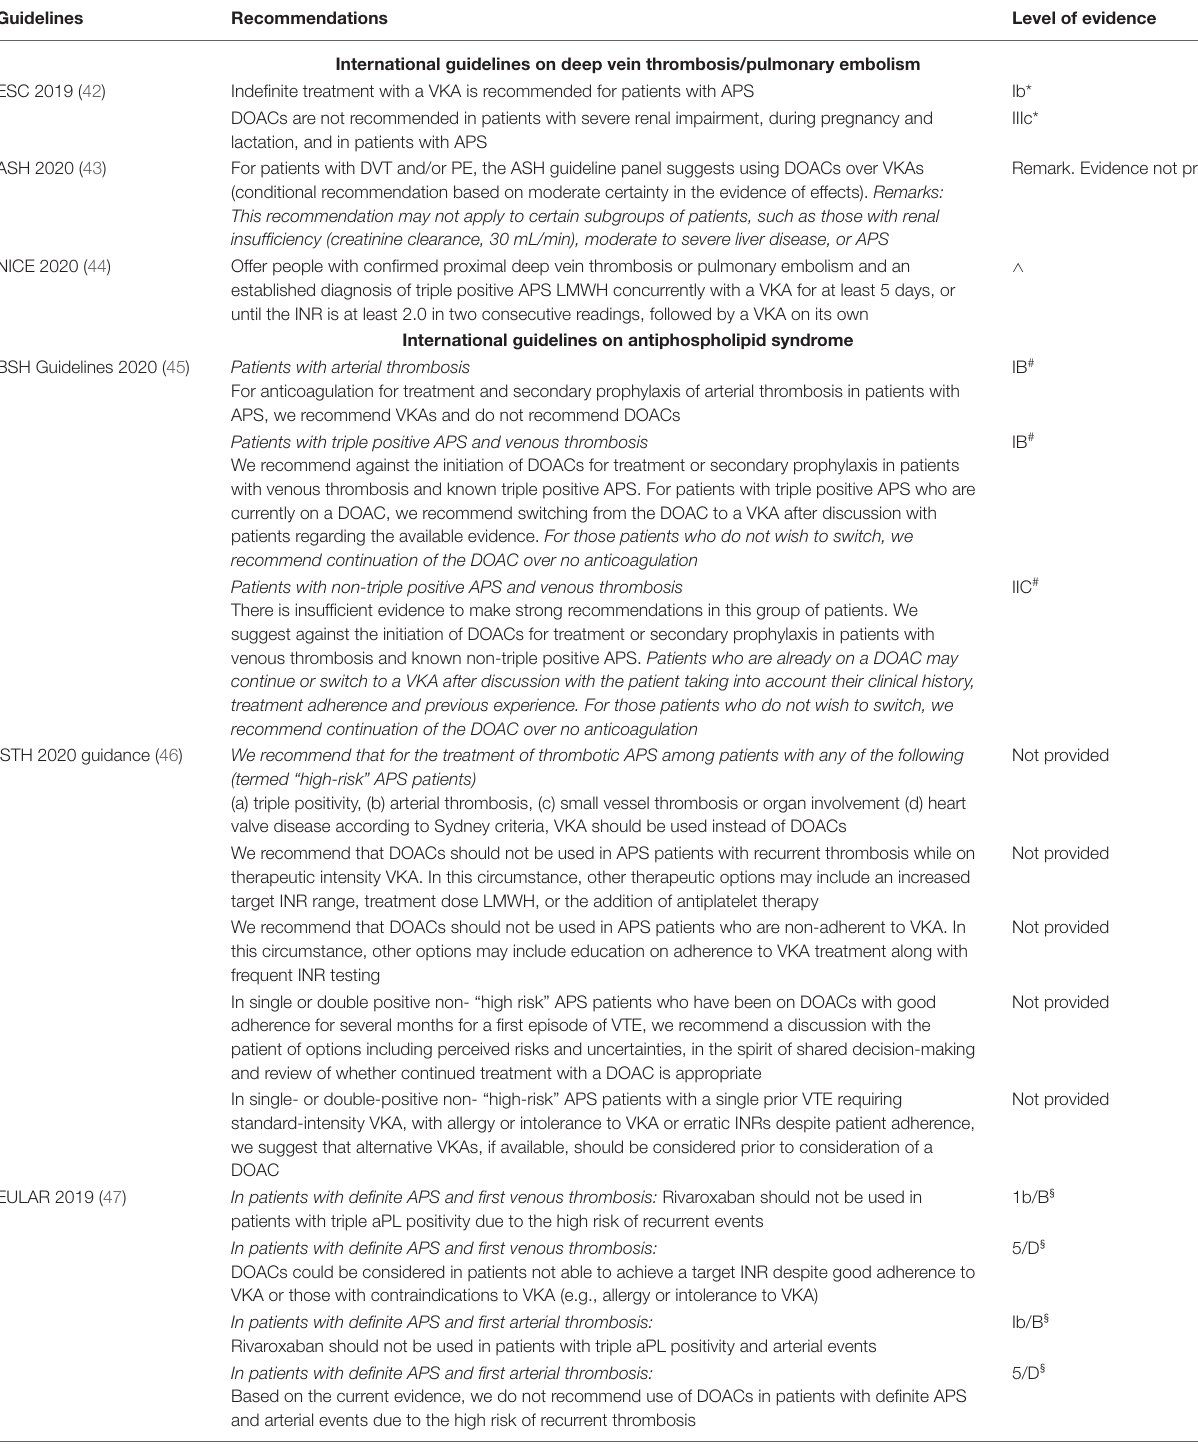
TABLE 3 | International guideline recommendations/consensus suggestions on the use of DOACs in APS patients.